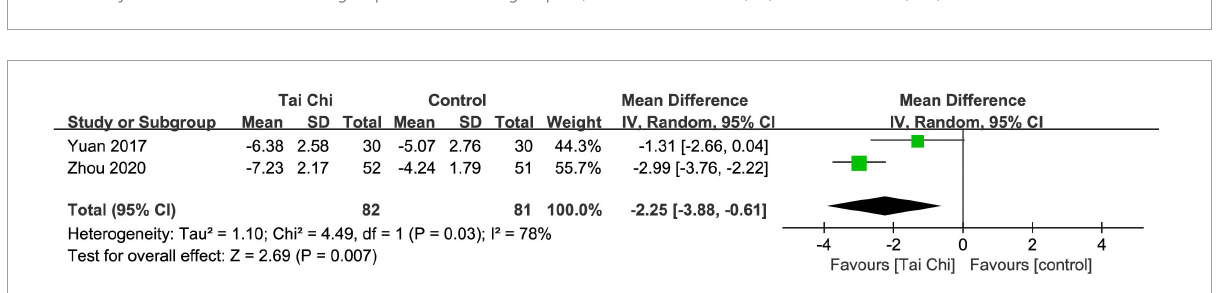
FIGURE8 Meta-analysis of PSQI in the Tai Chi group vs. the control group. CI, confidence interval; IV, inverse variance; SD, standard deviation.